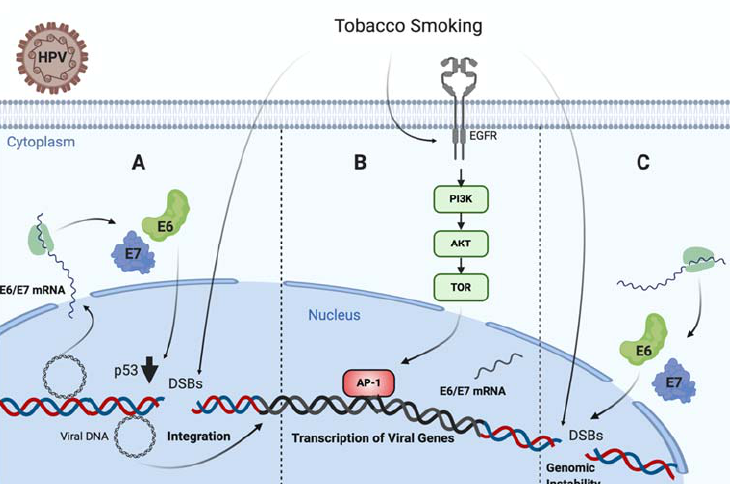
Figure 1. Tobacco smoke cooperates with high-risk human papillomavirus (HR-HPV) for increased DNA damage in epithelial cells. ( A ) Tobacco smoke causes E6 / E7 oveerexpression and DNA